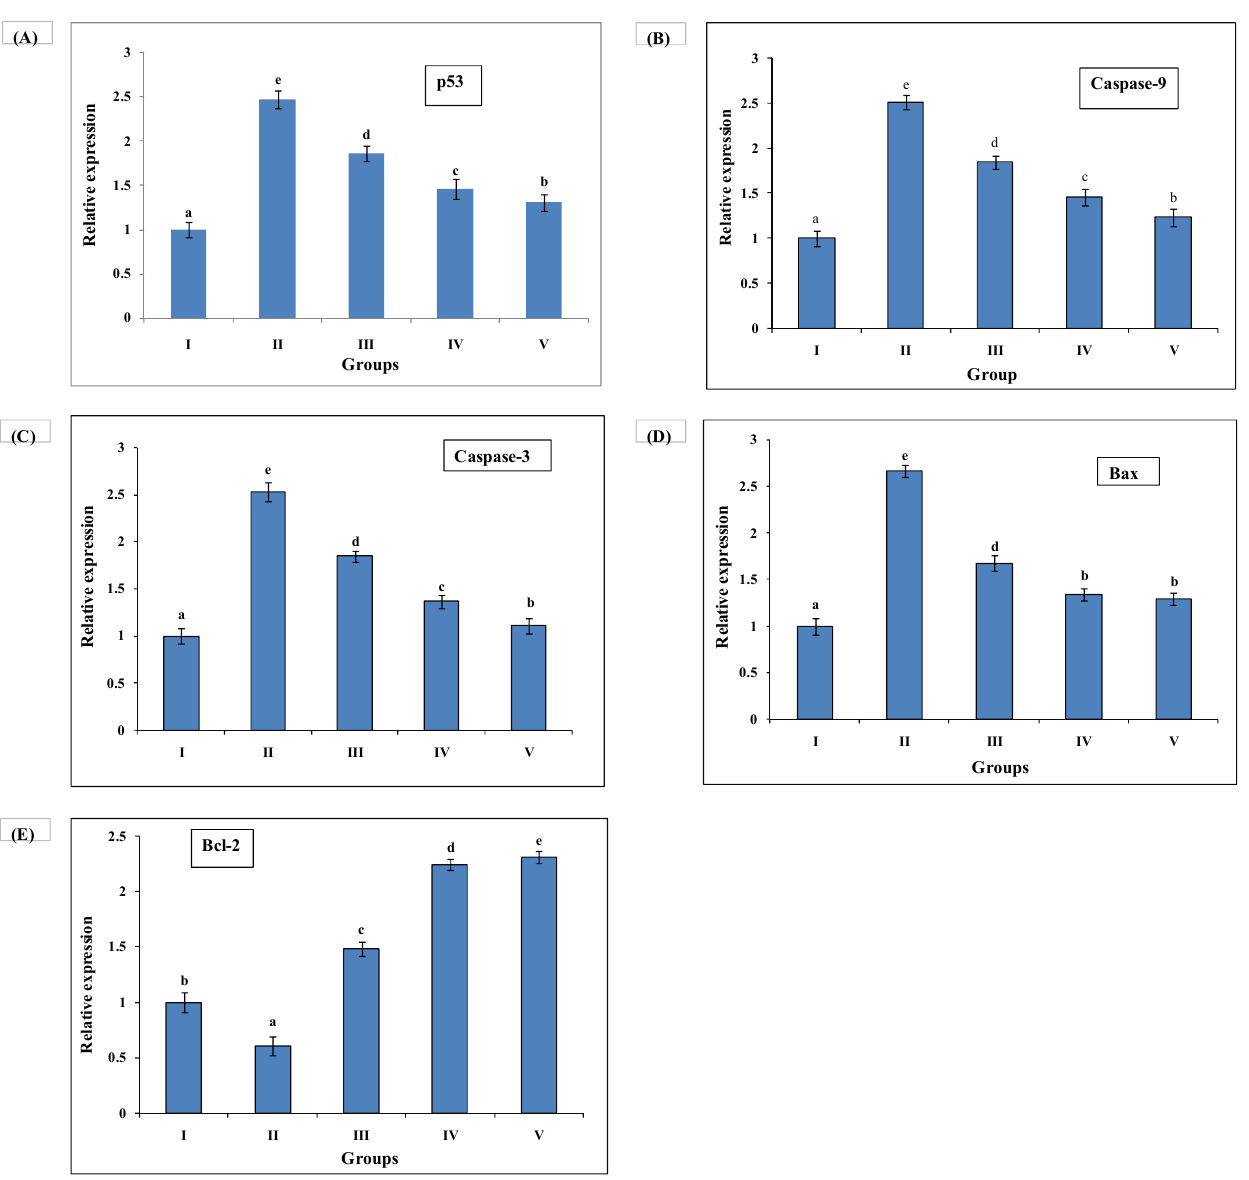
Figure 5. Relative expression of antiapoptotic and proapoptotic genes by qRT-PCR under MSG- induced liver toxicity. Relative expression of proapoptotic genes ( A ) p53, ( B ) caspase-9, ( C ) caspase-3, and ( D ) Bax was downregulated in all treatment groups as compared to Group II, and ( E ) expression of antiapoptotic gene Bcl-2 was upregulated. Duncan’s multiple-range test (DMRT) was used for analysis of a significant difference between means ( p < 0.05) and separately compared each parameter. Bars with the same letters were not significantly different. All values are means of five replicates ± SD.